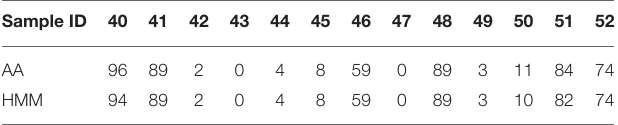
TABLE 2 | Abricate predicted unique AMR gene sequence counts in the URBAN dataset using amino-acid sequences from CARD v3.1.2 or HMMs from NCBI AMR to align to a